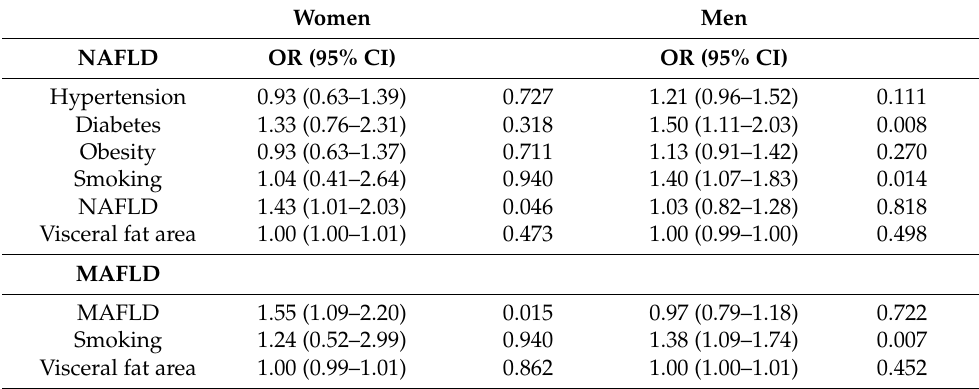
Table 3. Multivariate analyses of the risk for colorectal adenoma according to